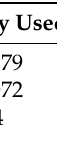
Table 3. System hardware resource @150